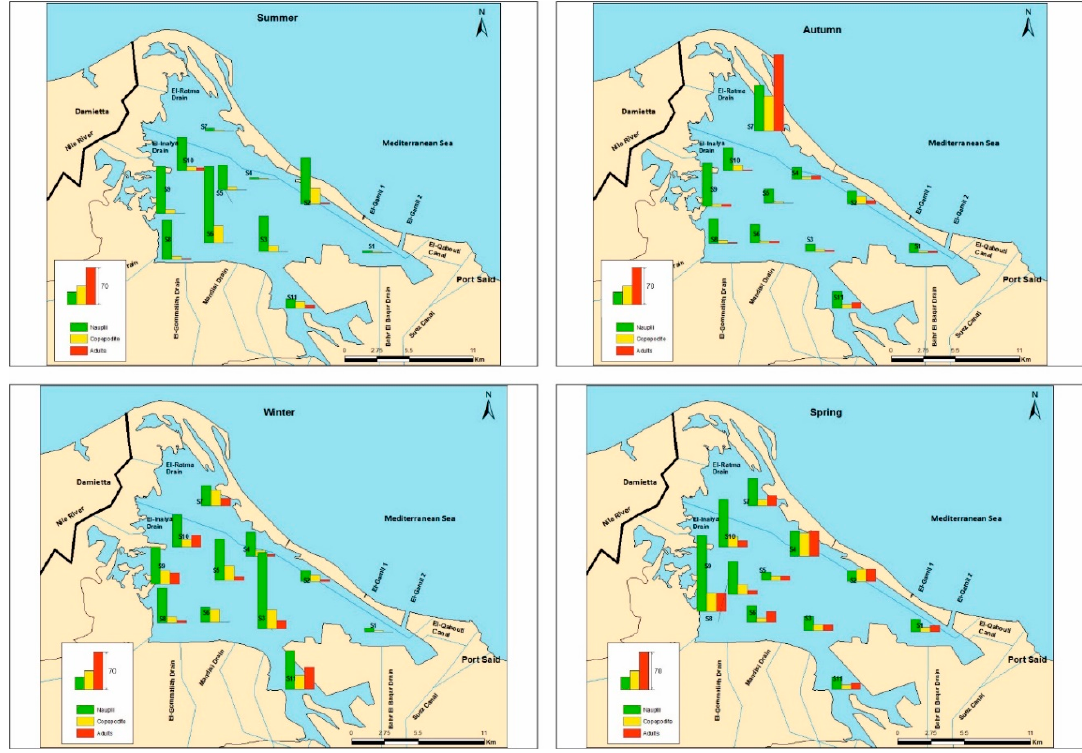
Figure 5. Spatiotemporal variations of copepod demographic class abundance: nauplii, copepodids, and adults in Lake Manzalah.